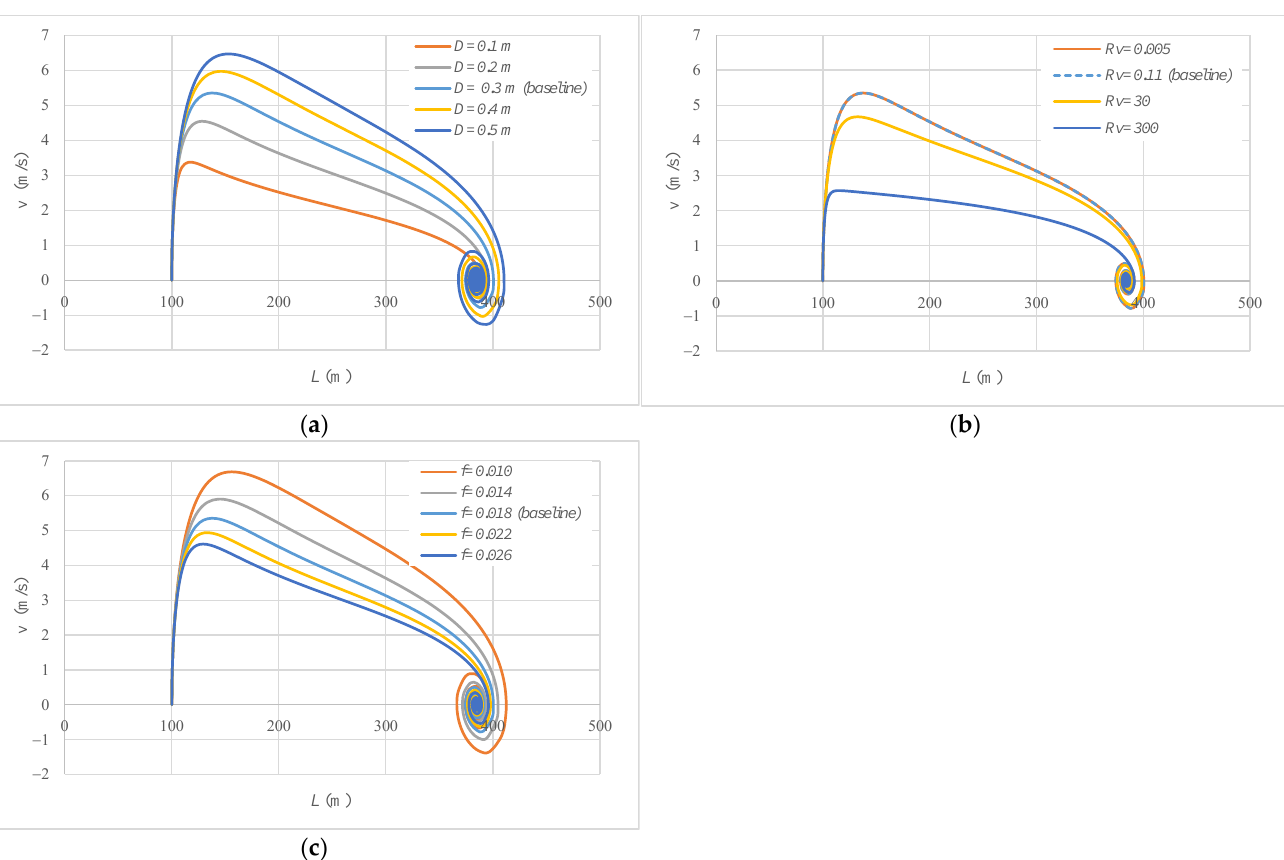
Figure 7. Sensitivity analysis for non-dependent parameters: ( a ) internal pipe diameter ( 𝐷 ); ( b ) resistance coefficient of a regulating valve ( 𝑅 𝑣 ); and ( c ) friction factor ( 𝑓 ) .